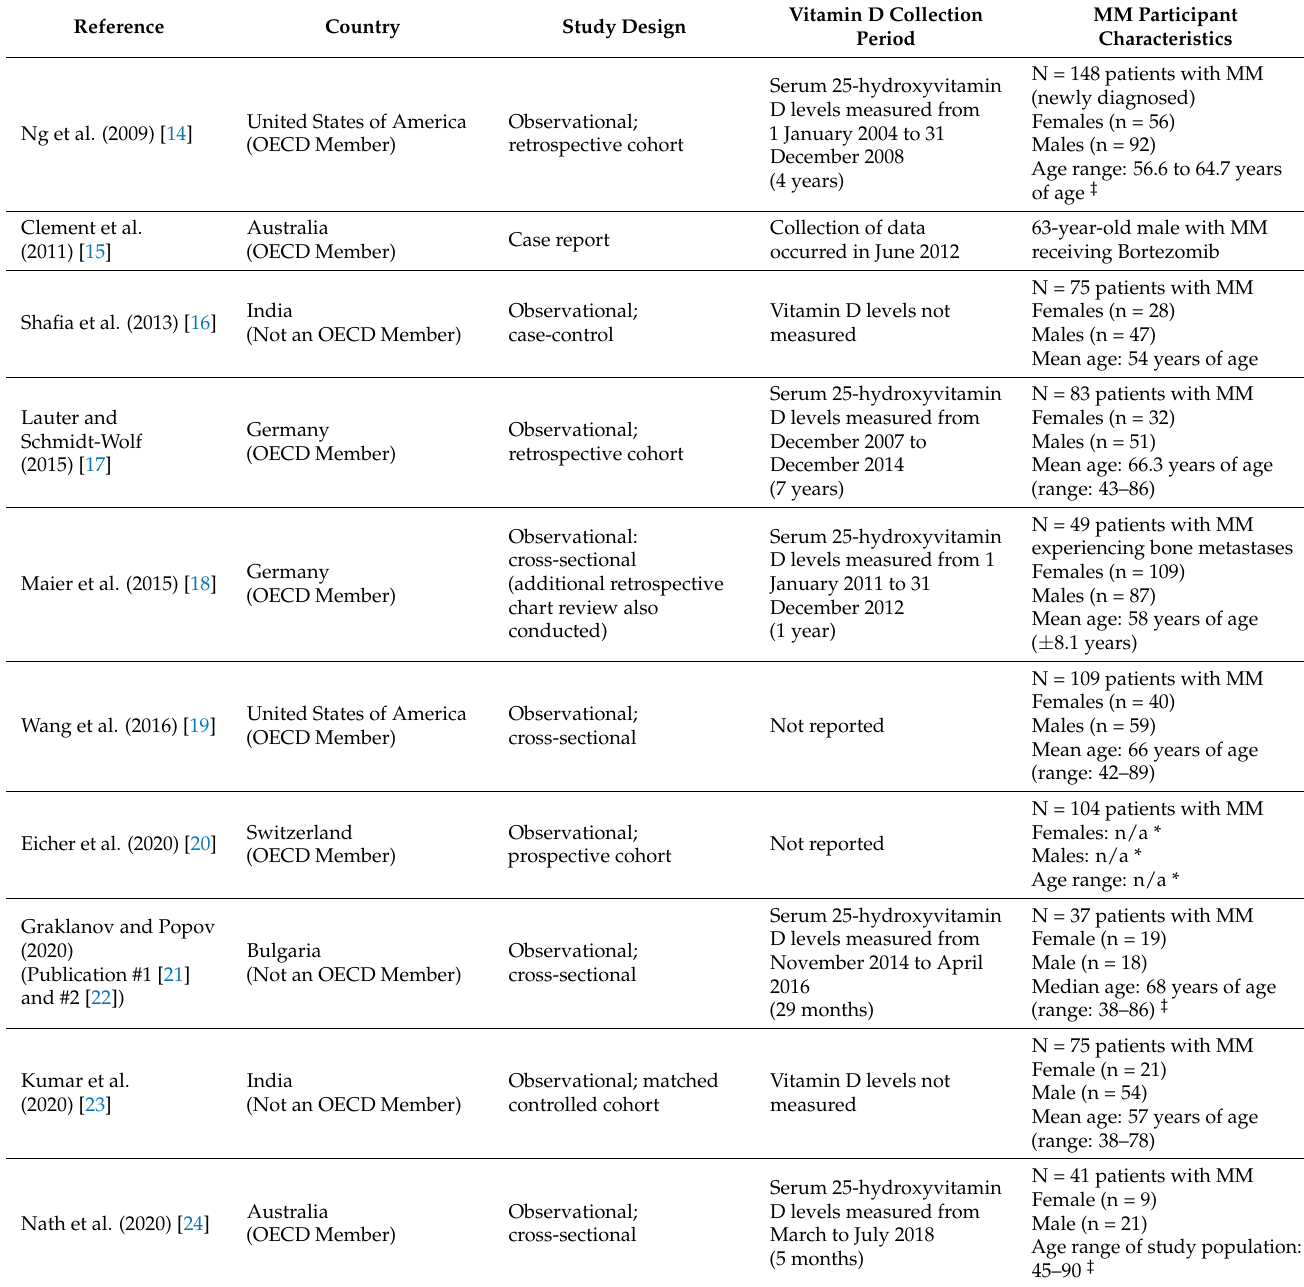
Table 1. Characteristics of the included